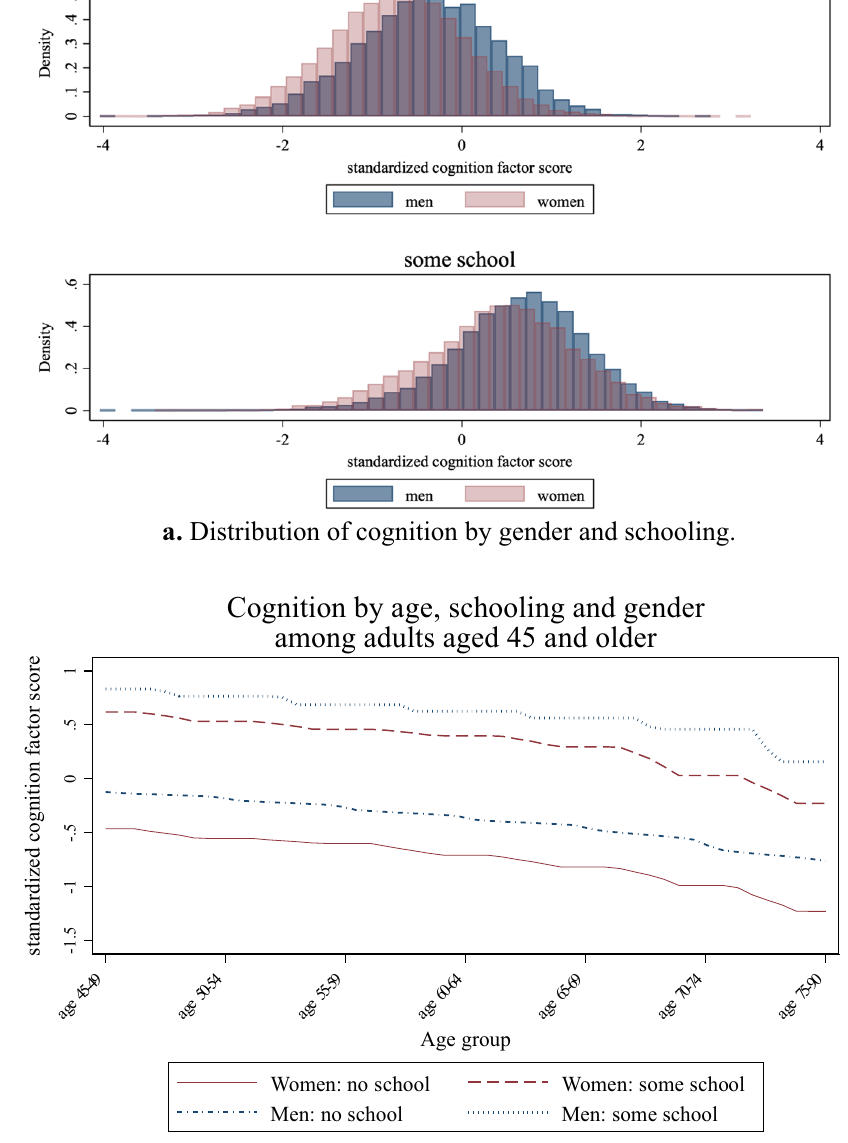
Figure 1. ( a ) Distribution of cognition by gender and schooling. ( b ) Cognition by gender, schooling and